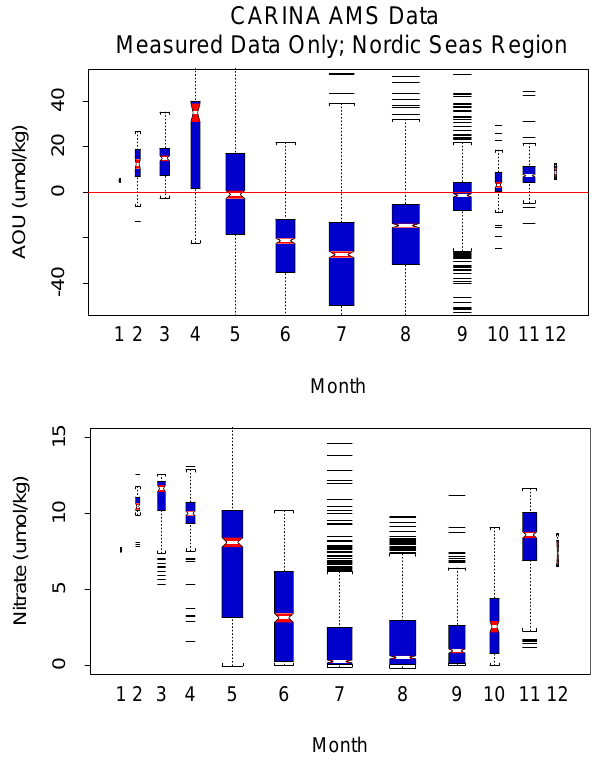
Figure 4. These two boxplots were generated using measured val- ues from the AMS data product. The data selected are from the up- per 25m of the Nordic Seas region. The box widths are proportional to the number of data included. Even though a substantial fraction of the data were adjusted as part of the 2nd QC work, the seasonal cycle in these two parameters is retained. The near surface DIC data from this region have the same trend. Similar analyses with other parameters and other regions demonstrate that the 2nd QC proce- dure has not “erased” strong temporal signals. Investigation of more subtle signals such as the expected temporal increase in near surface DIC due to anthropogenic CO 2 will require more careful